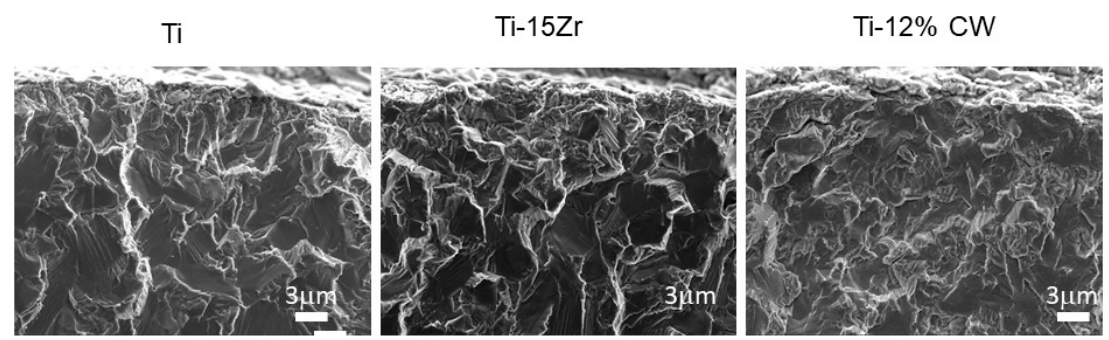
Figure 6. Fractography of the narrow dental implants.